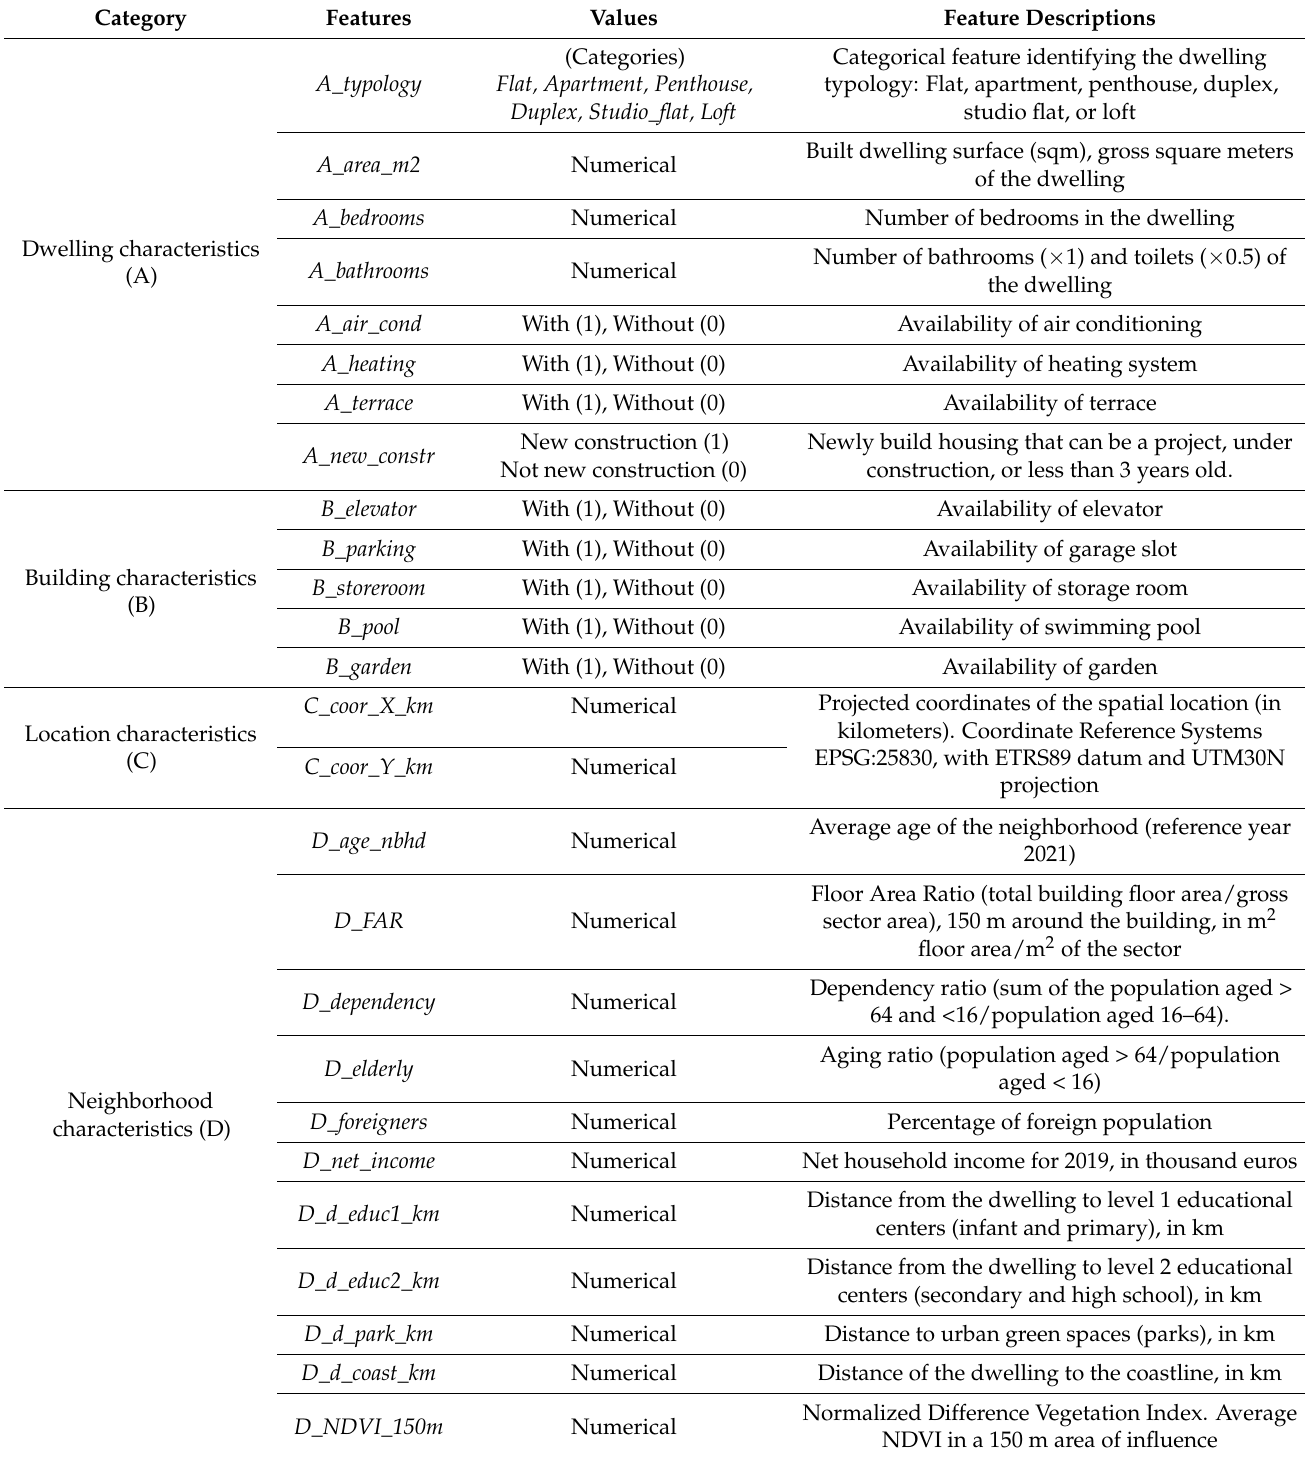
Table 1. Set of features that make up the study, with their units and